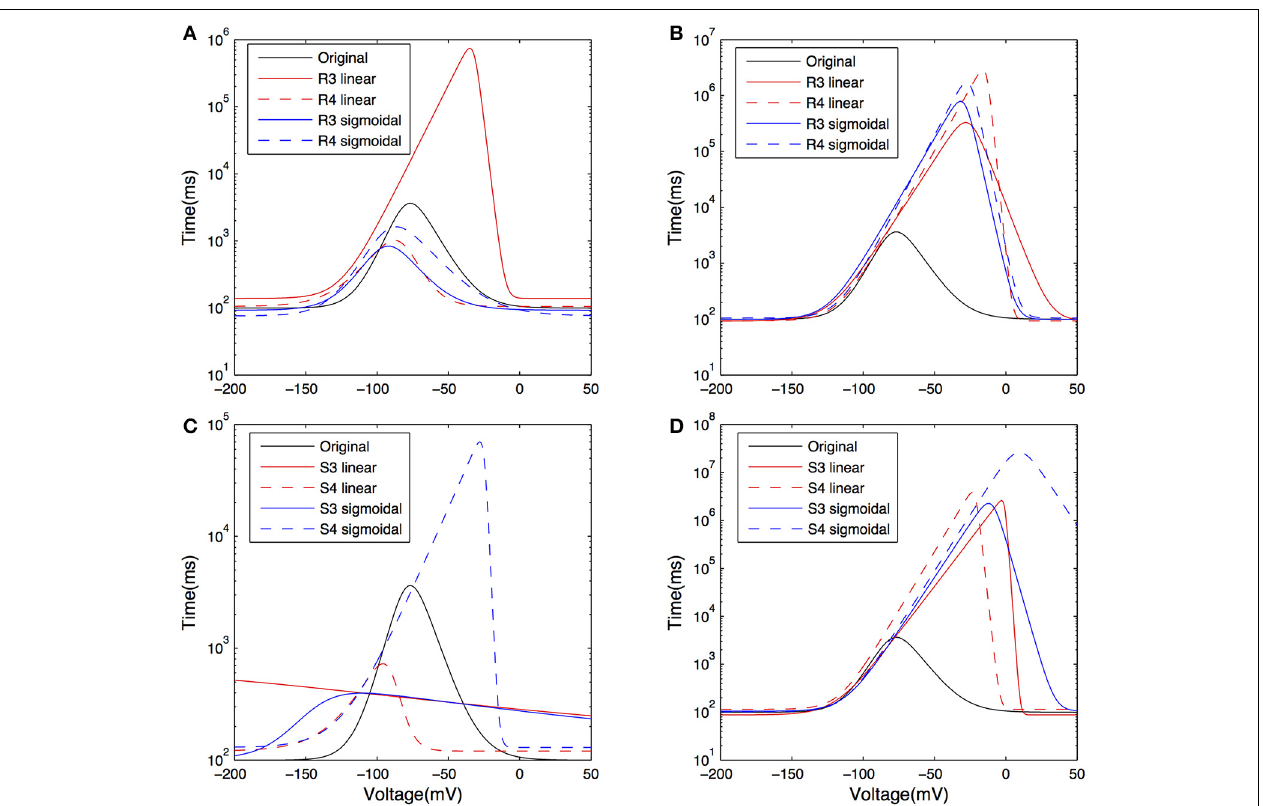
FIGURE 8 | Plots of the activation time constant curves of I h for the models after optimization. Curves showing the time constant of activation for I h , or τ , vs. voltage on a semi-log plot, for models with both morphologies and R m , C m , t 1 , t 2 , ..., t 8 , and dendritic scaling factor k d for dendritic